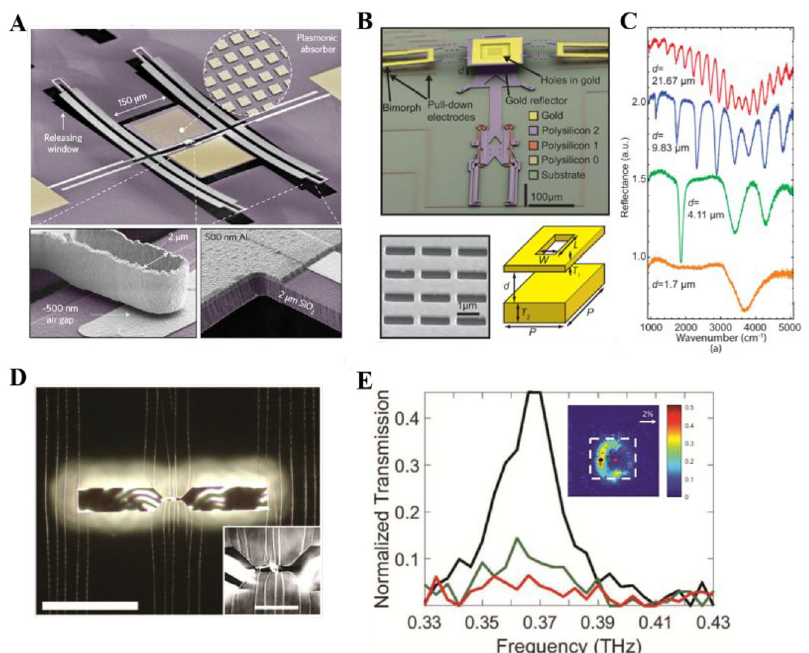
tance between two gold layers eliminates the higher-order resonances so that the number of dips drops. The quality